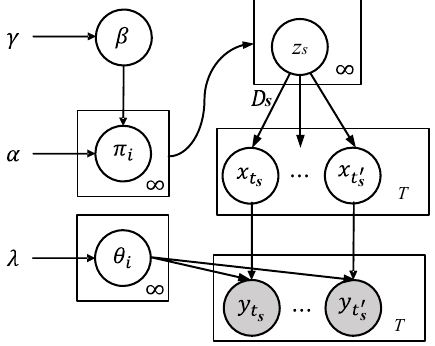
Figure 8. The HDP–HSMM graphical model.